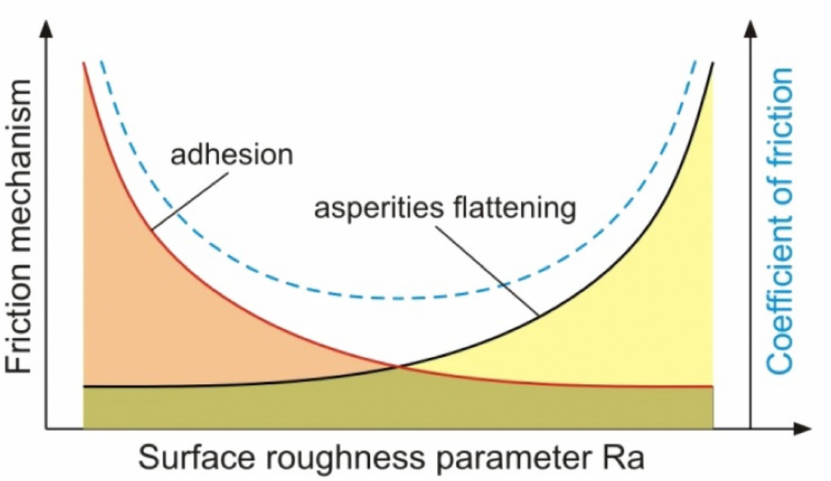
Figure 11. Phenomena affecting frictional resistances. Reproduced with permission from Ref. [25]; published by Elsevier, 2022.